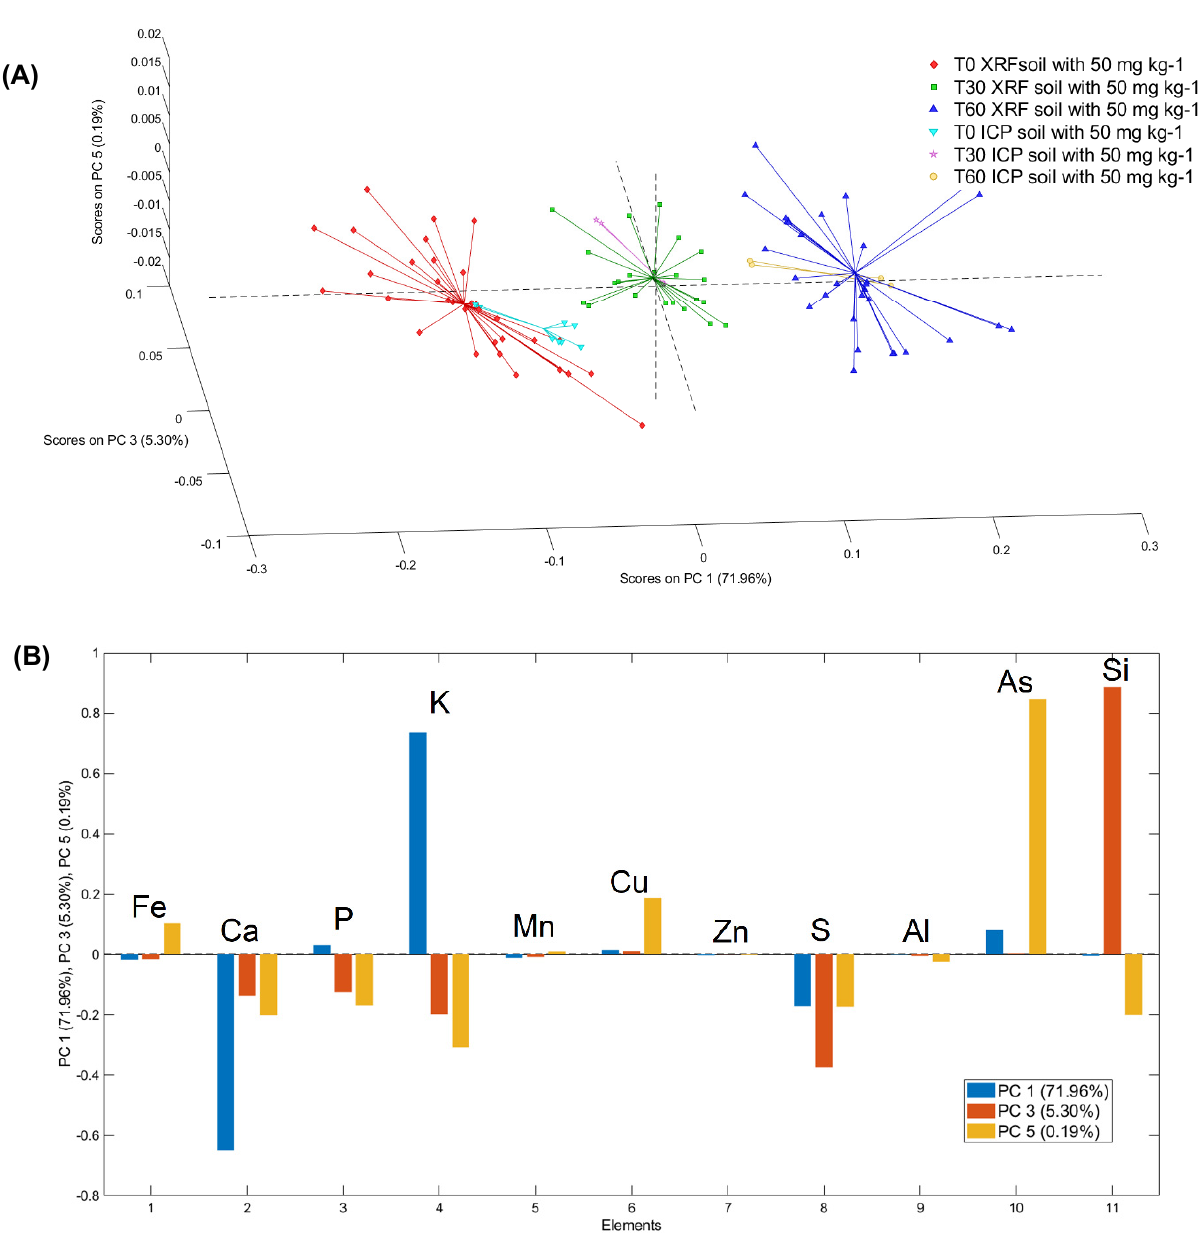
Figure 6. 3D PCA ( A ) score and ( B ) loading (PC1, PC3, PC5) plots of µXRF and ICP–OES data for T0, T30 and T60 for plants grown on soil S1.